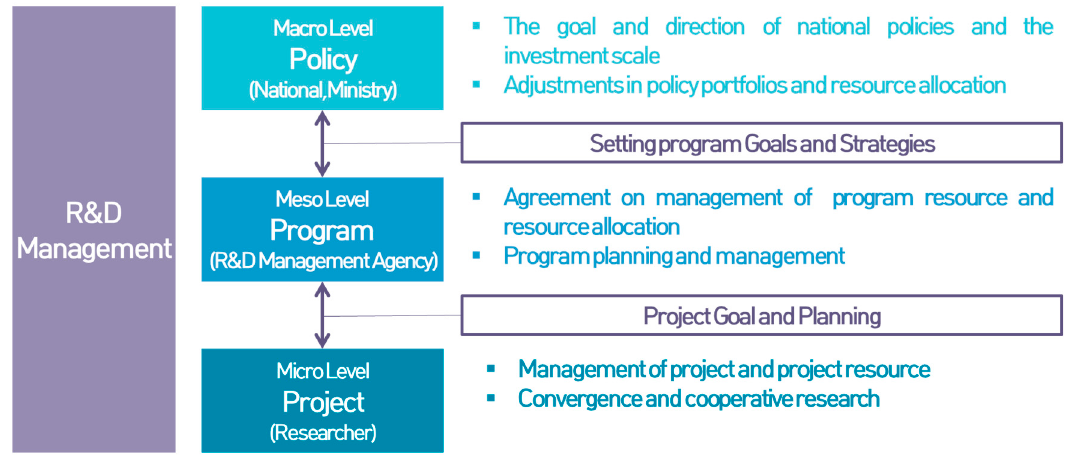
Figure 2. Levels of managing science and technology policies, programs, and projects. Source: [2].